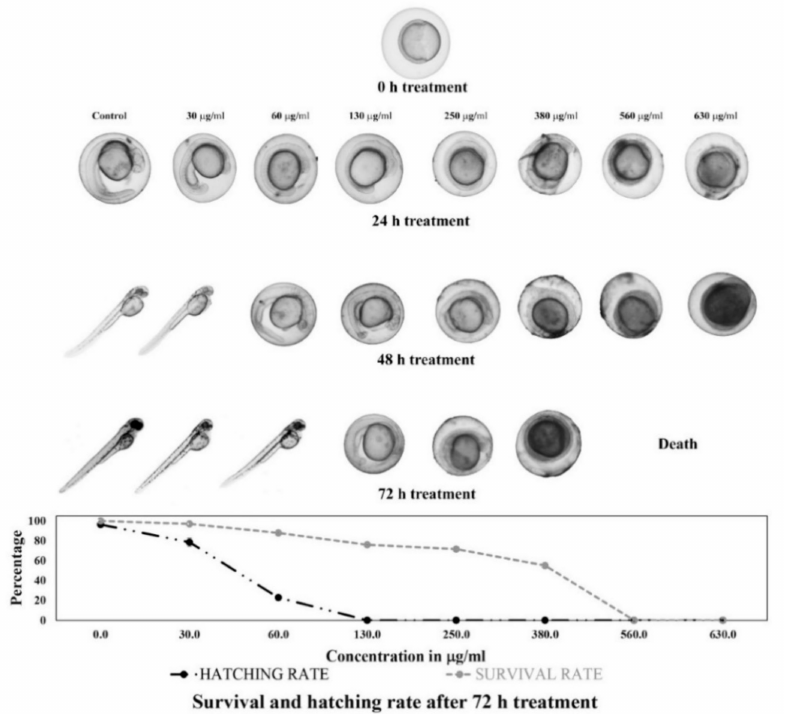
Figure 2. In vivo developmental effect of Jussiaea repens L. The developmental effect of J. repens L. in the developing embryo of zebrafish (0–6 hpf) was studied by treating the embryo with different plant extract concentrations. The line graph represents the hatching rate and survival